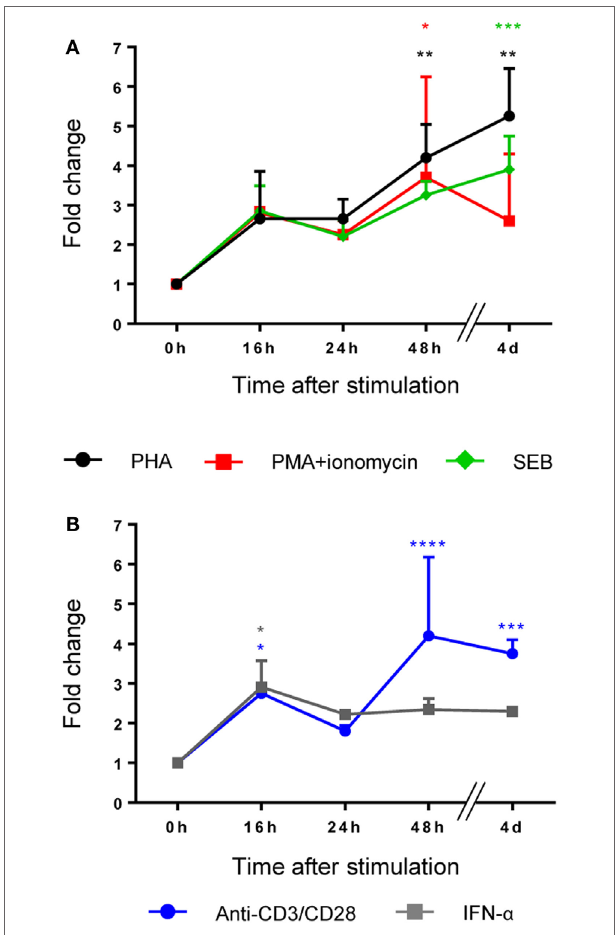
FIGURe 1 | A broad panel of stimuli promotes the expression of LRBA protein in total peripheral blood mononuclear cells (PBMCs). PBMCs from healthy donors were stimulated with (A) phytohaemagglutinin (PHA), PMA + ionomycin and staphylococcal enterotoxin B (SEB) (B) anti-CD3/ anti-CD28 and IFN- α , during 16, 24, 48 h, and 4 days. Values are presented as mean fluorescence intensity fold changes from time 0 h which was normalized to one. All stimulation conditions and time points were performed in three samples independently. Statistical analysis was done comparing 0 h with 16, 24, 48, or 4 days, respectively, after